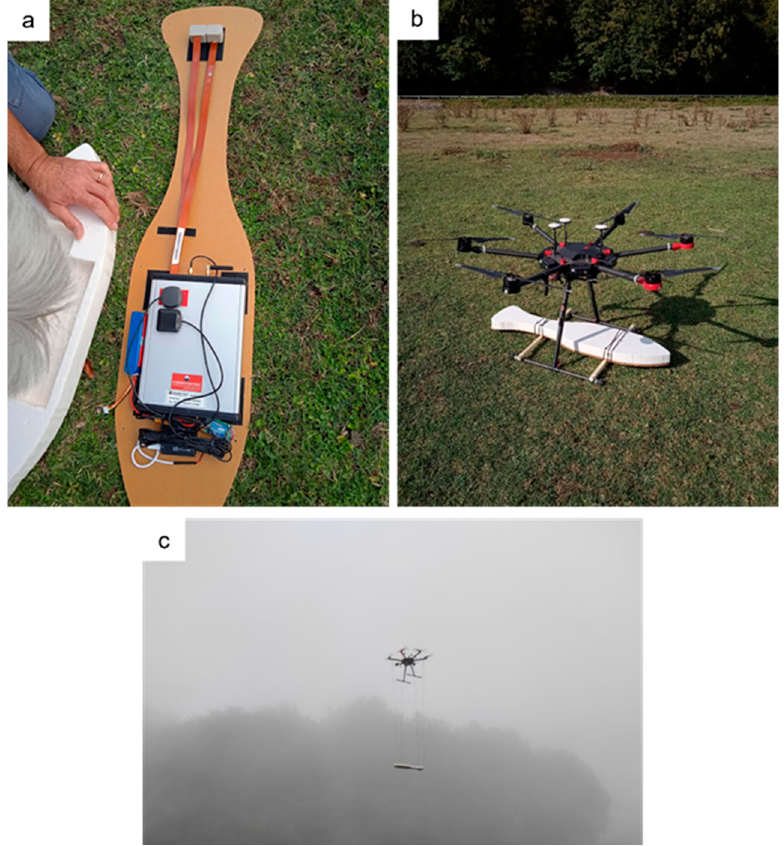
Figure 1. ( a ) Arrangement of the GEOMETRICS MFAM “Development kit” magnetometer inside the bird; ( b ) first flight configuration (F0.5), with the magnetometer fixed to the UAV landing sled, 0.5 m below the platform; ( c ) second flight configuration (F3.0), with the magnetometer suspended 3 m below the UAV.